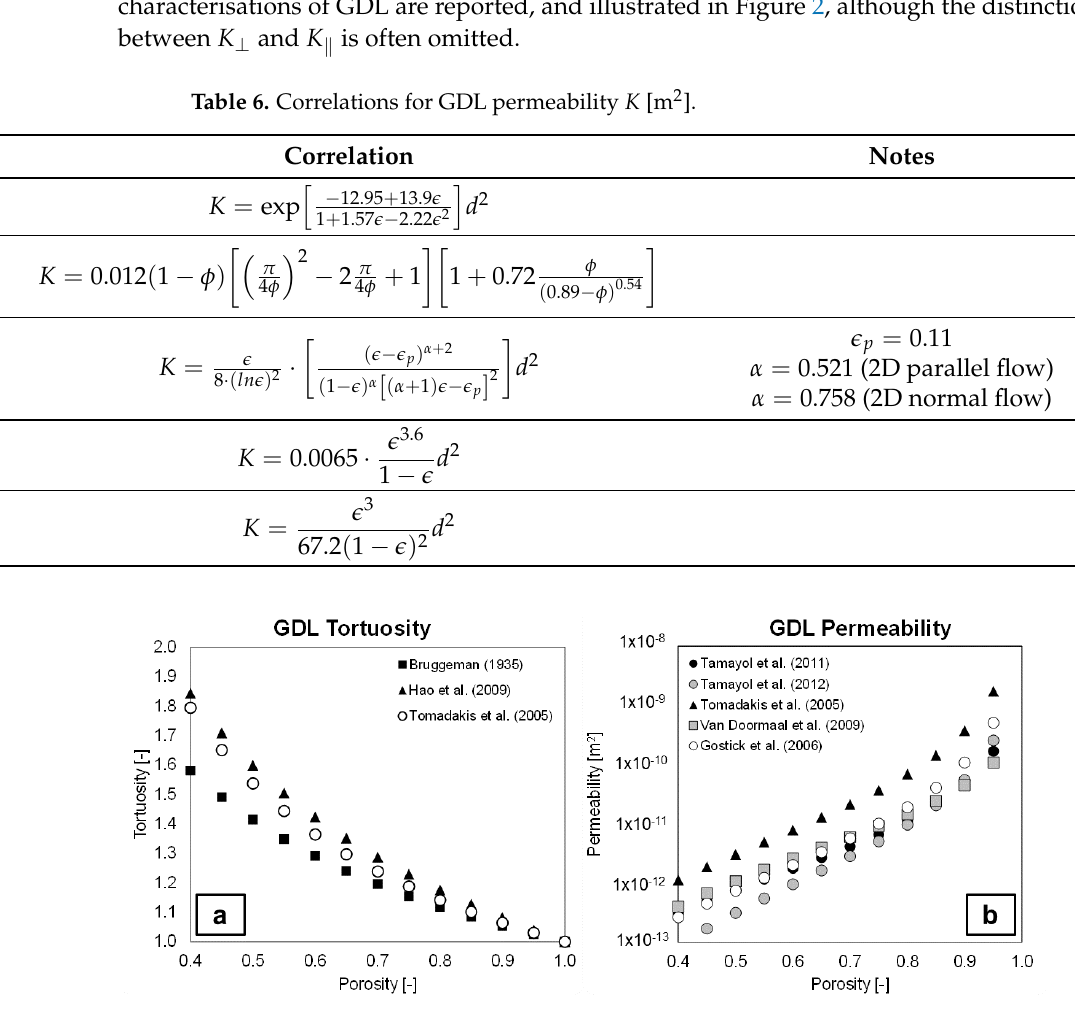
Figure 2. Correlations for GDL tortuosity from Table 5 (left, ( a )) and correlations for GDL permeability from Table 6 (right, ( b )) as a function of the GDL porosity (cid:101)